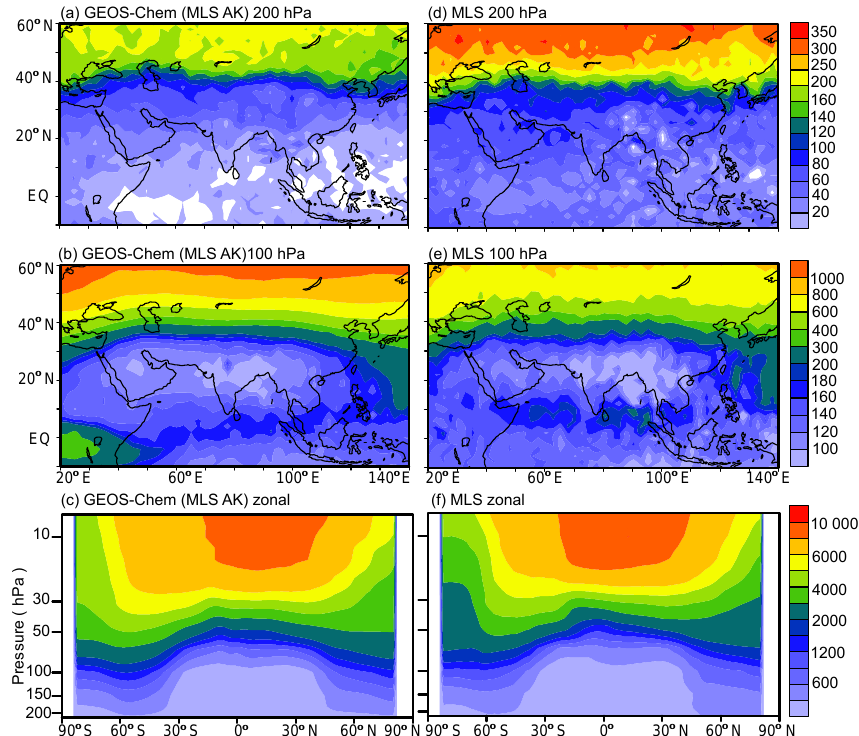
Figure 5. Comparisons of simulated O 3 concentrations (ppbv) with observations (ppbv) from MLS. Panels (a) and (b) show simulated concentrations at 200 and 100hPa, respectively. Panel (c) shows the latitude–altitude cross section of simulated O 3 concentrations averaged over 70–105 ◦ E. Panels (d) – (f) are the same as (a) – (c) , except that (d) – (f) show observations from MLS. The GEOS-Chem O 3 simulations are smoothed by the corresponding averaging kernels. White areas indicate lack of data meeting the retrieval quality criteria. All the data are averaged over June–August of